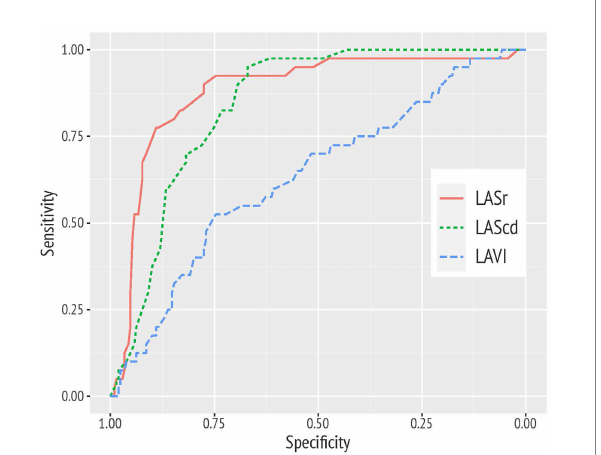
FIGURE 3 Receiver operating characteristic (ROC) curve analysis demonstrating the superior diagnostic value of left atrial reservoir strain (LASr) and conduit strain (LAScd) compared to left atrial volume index (LAVI) to discriminate study participants with a worsening of diastolic function over